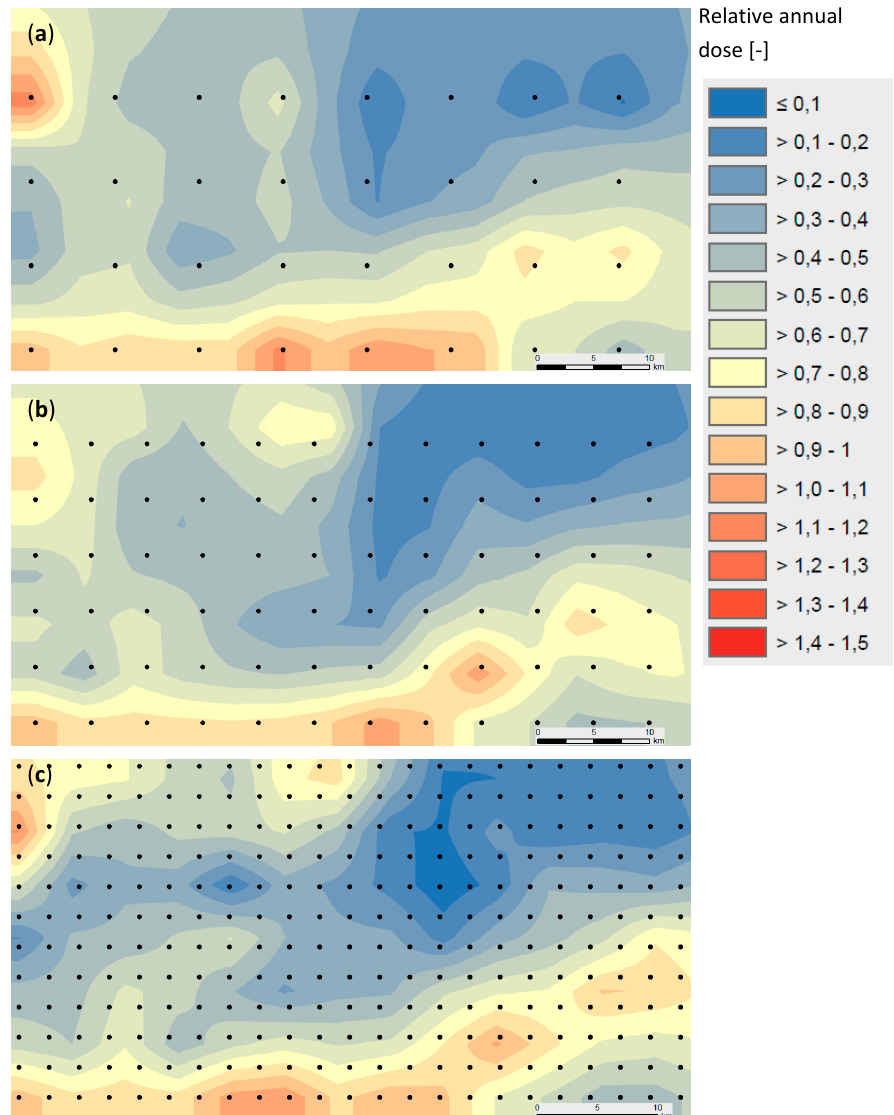
Figure 5. Relative annual dose in Lötschental based on exposure model EM 2 and the simplified logistic decay model SLM at different resolutions, reference location: Uppsala, Sweden. ( a ): 7.5 × 7.5 km, ( b ): 5.0 × 5.0 km, ( c ): 2.5 × 2.5 km.